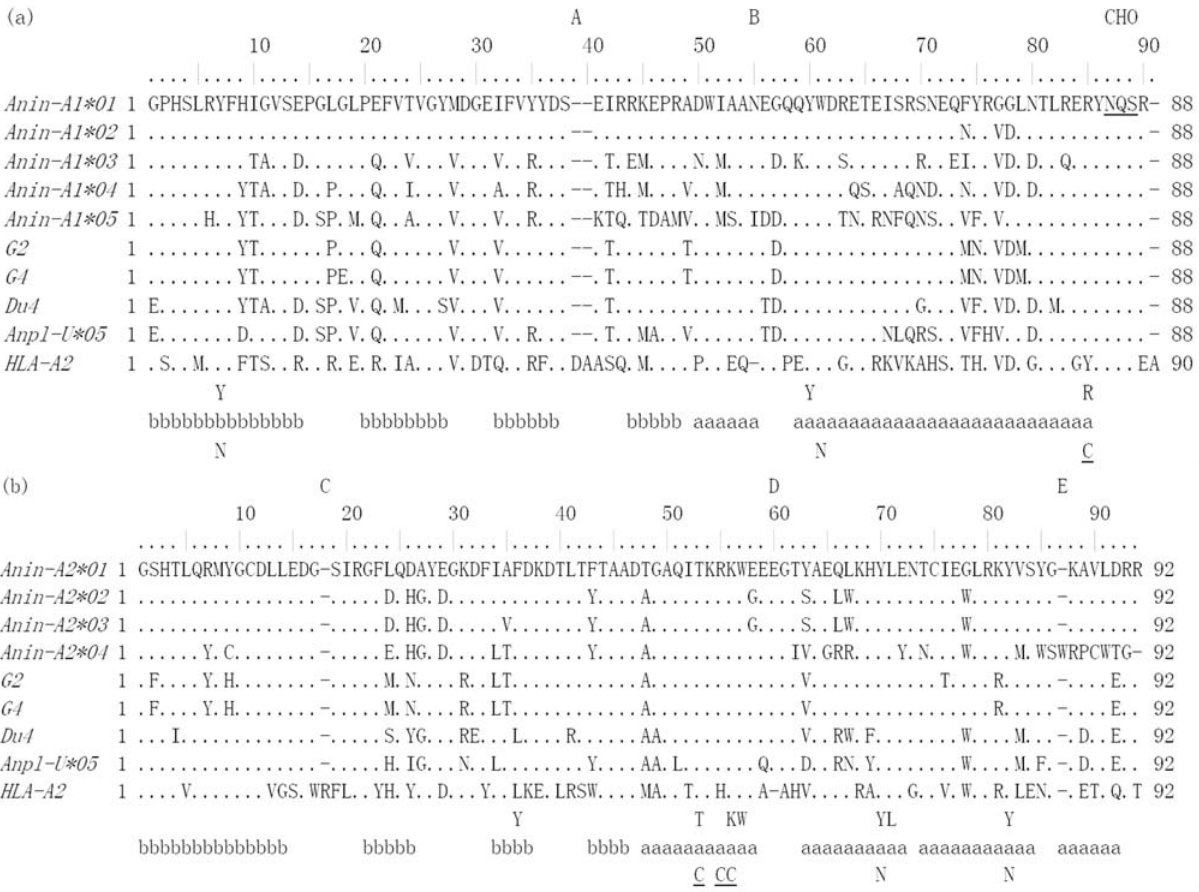
Figure 1 - Alignment of the predicted MHC class I (a) (cid:2) 1 and (b) (cid:2) 2 domain amino acid sequence of bar-headed goose, goose ( G2 , AY387649; G4 , AY387651), duck ( Du4 , AB115244; Anpl-U*05 , AY294419), and human ( HLA-A2 , K02883). The first amino acid of the (cid:2) 1 and (cid:2) 2 domain is consid- ered as position 1 separately. Amino acid identity with Anin-A1*01 and Anin-A2*01 is shown by dot. Conserved amino acid residues involved in binding the peptide-terminal main chain atoms are indicated below the alignment (Moon et al. , 2005). aaaaa alpha helix; bbbbb beta strand; N or C residues bind- ing peptide NH2- or COOH- termini; CHO glycosylation site; A, B, C, D, E observed indels between the bar-headed goose sequences and HLA-A2 . The N-linked glycosylation sites are underlined.